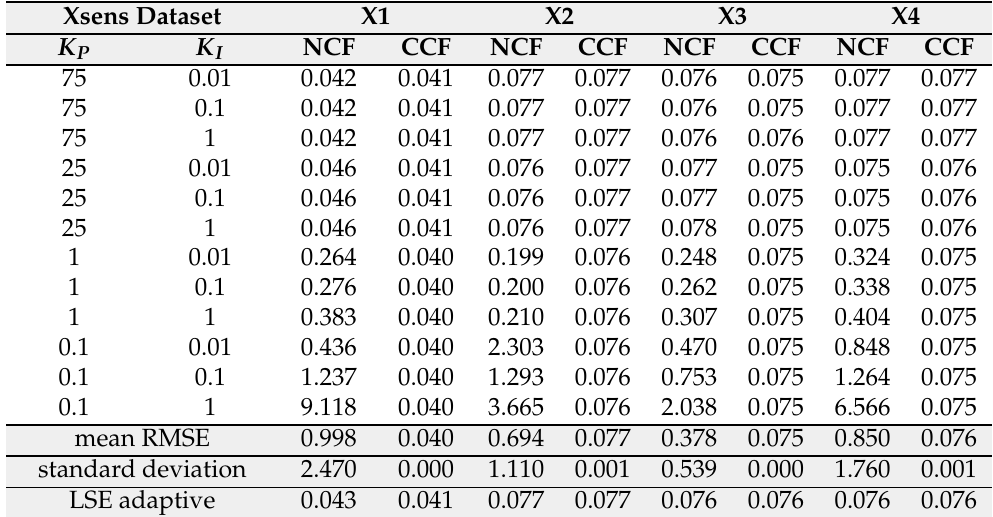
Table 1. Average RMSE (in radian) obtained for NCF and CCF with varying K P and K I (Xsens